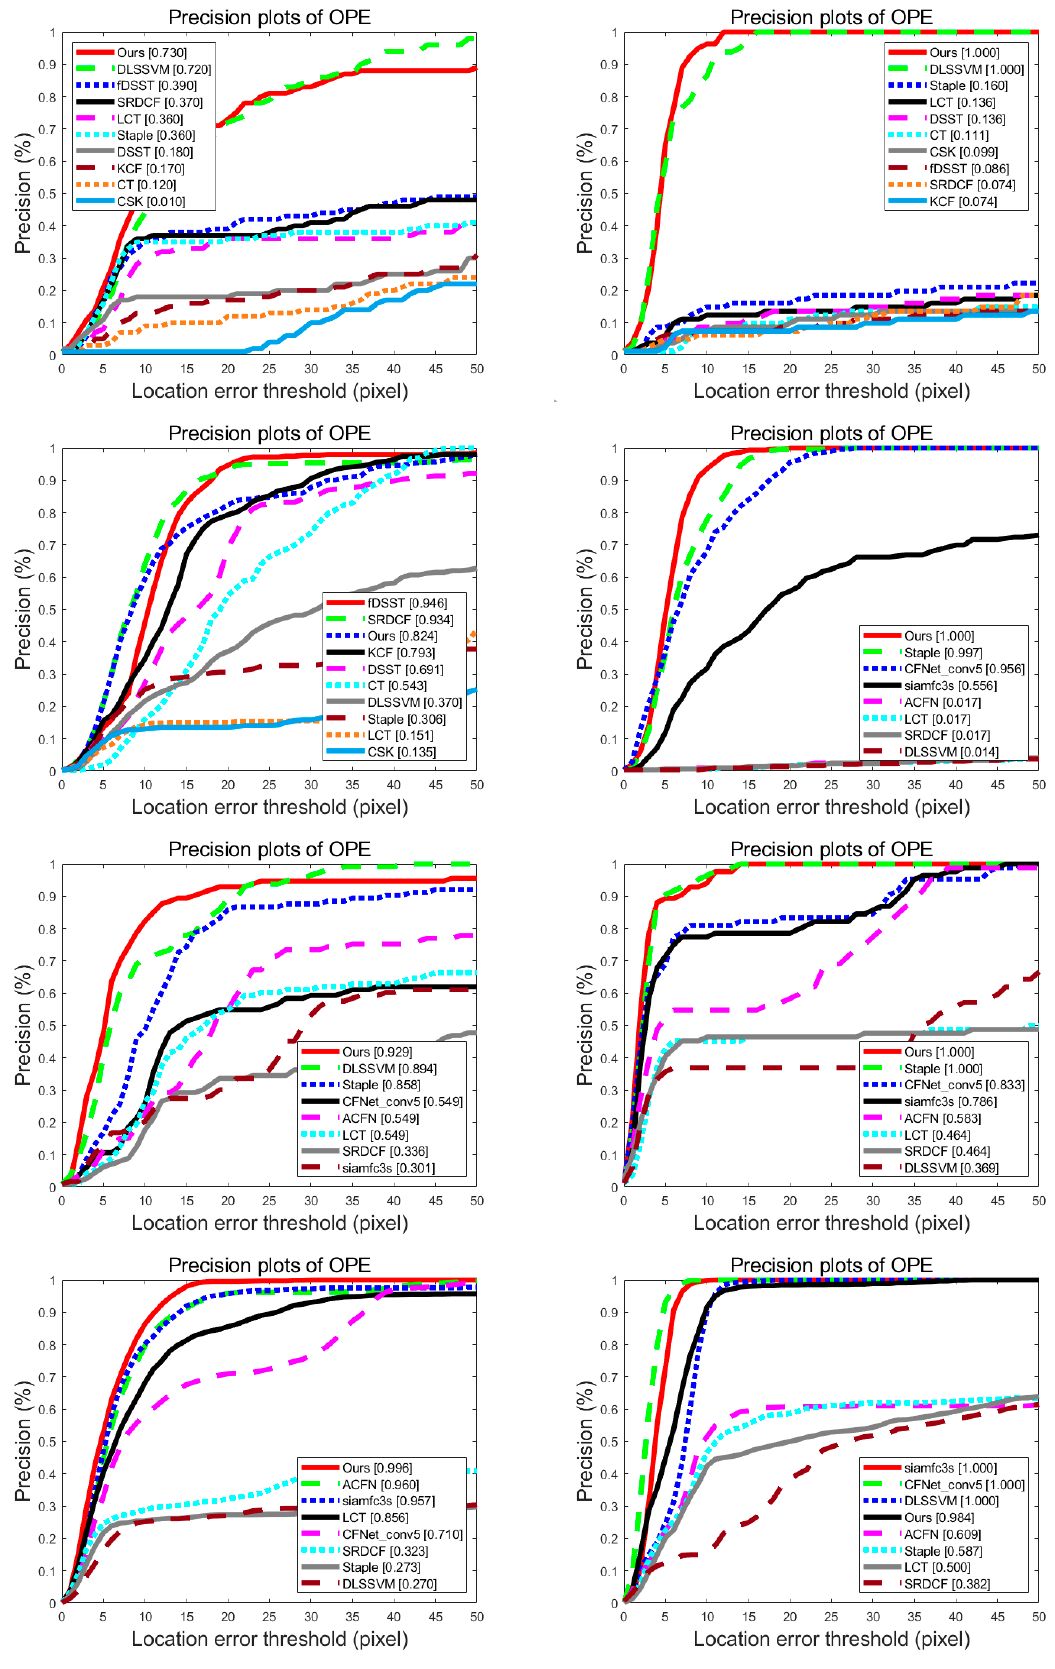
Figure 9. Precision plots of OPE on the tested sequences.